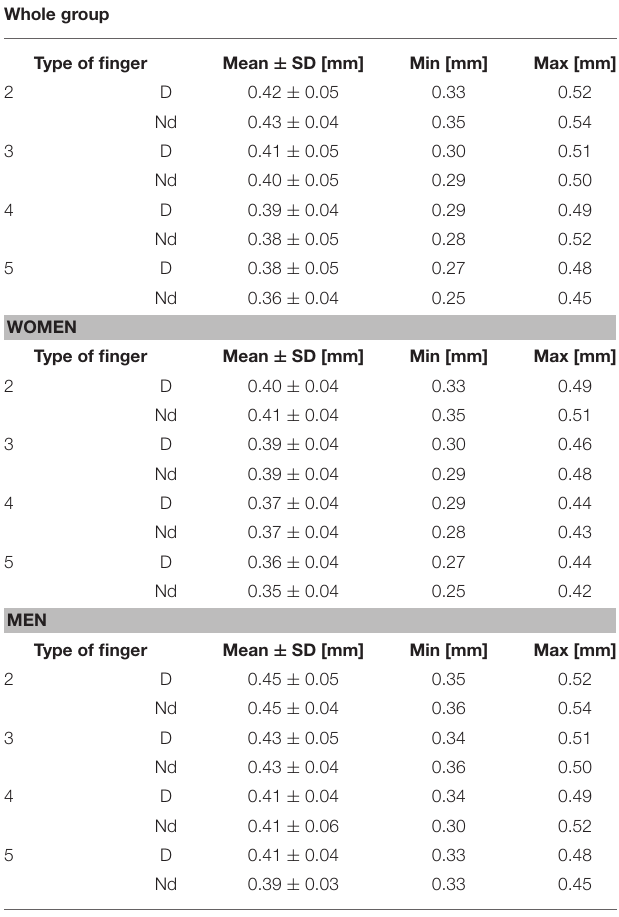
TABLE 2 | The thickness of nail plates in the whole group and in the group of women and men. Whole group